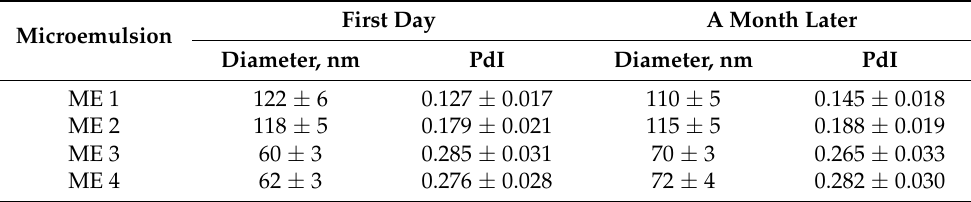
Table 2. Stability of the microemulsions over time: the size and degree of polydispersity (PdI) of particles (25 ◦